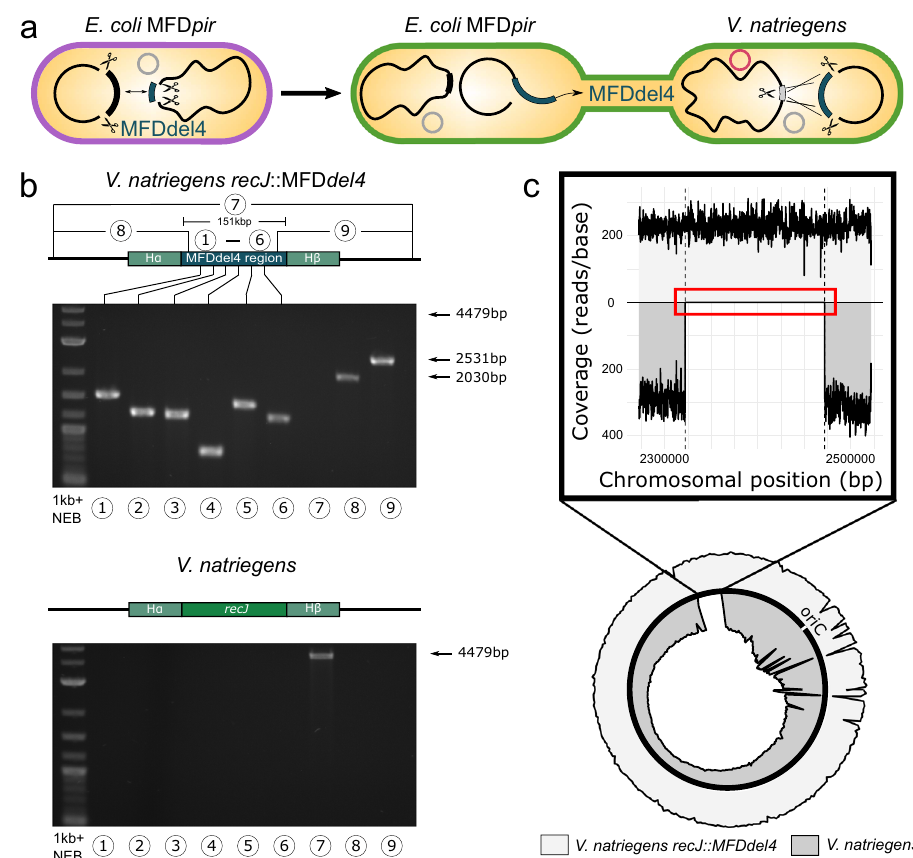
Fig. 7 Integration of a 151 kb E. coli chromosomal region into the V. natriegens chromosome. a Scheme of the swap and conjugational transfer of the 151 kb MFDdel4 chromosomal region from E. coli to V. natriegens and subsequent integration. Cell colours represent the corresponding editing step. b Shown are agarose gels of PCRs from the transfer and integration of a 151 kb chromosomal region from E. coli into the recJ locus of V. natriegens . PCRs were done for the acceptor strain ( V. natriegens ) and for the edited strain ( V. natriegensrecJ ::MFDdel4). PCRs “ 1 – 6 ” result in the ampli fi cation of evenly distributed fragments of the E. coli del4 region within the V. natriegens chromosome. PCR “ 7 ” results in the ampli fi cation of a 4479bp fragment, if the recJ locus is unchanged. PCR “ 8 ” and “ 9 ” amplify the transition of the del4 region to the adjacent chromosomal regions. PCR was repeated once with identical results. Chromosomal overviews including homologous regions (H α , H β of each PCR are shown above each agarose gel. c Shown is the next-generation sequencing (NGS) coverage of the edited strain V. natriegensrecJ ::MFDdel4 (light grey) compared to the reference V. natriegens strain (dark grey). Both NGS reads were aligned against the edited reference genome ( recJ ::MFDdel4). The sector of the del4 insertion as well as the complete genome coverage (circle) are shown. Reads of the complete del4 insertion (between dashed lines) are present for the edited strain, while no reads are present for the wild- type strain (red lacZ ::RP4 strain was tested by transfer of a pSwap plasmid from D. dadantii to E. coli DH5 α (see Fig. 9b). The established con-